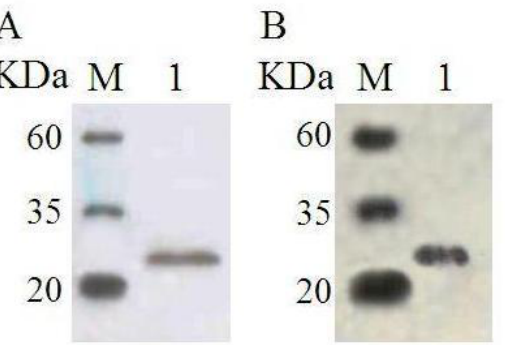
Figure 3. Western blot analysis of rgVEGF164. (A) Western blot analysis of rgVEGF164 with monoclonal anti-His antibody. Lane 1, purified rgVEGF164; M , PM Western Midview Marker (CW0021, Beijing ComWin Biotech Co. Ltd., Beijing, China). (B) Western blot analysis of rgVEGF164 with monoclonal anti-VEGF antibody. Lane 1, purified rgVEGF164; M , PM Western Midview